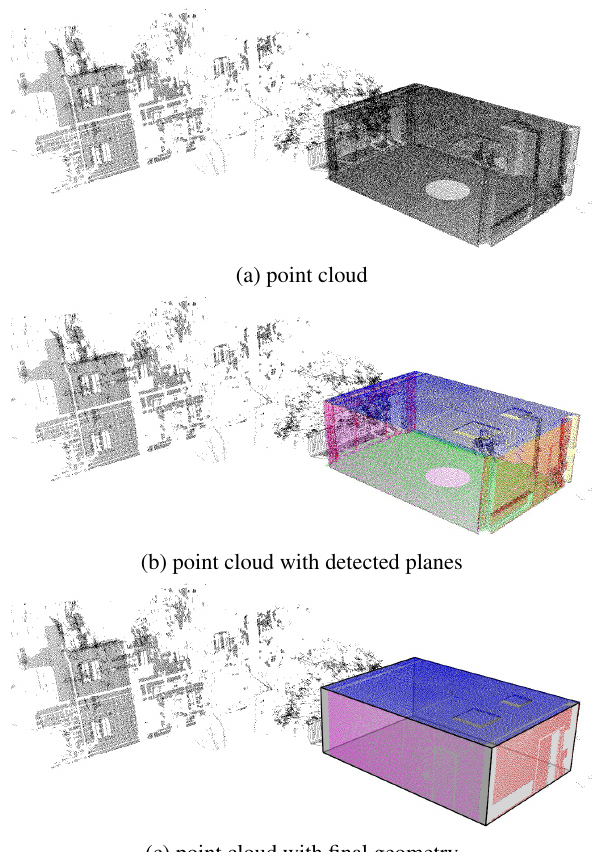
Figure 5: A coarse 3D model is created from the point cloud (a) using algorithmic clustering of the point cloud into walls, ceiling and floor (b), from which a simplified model with quadrilateral faces is created